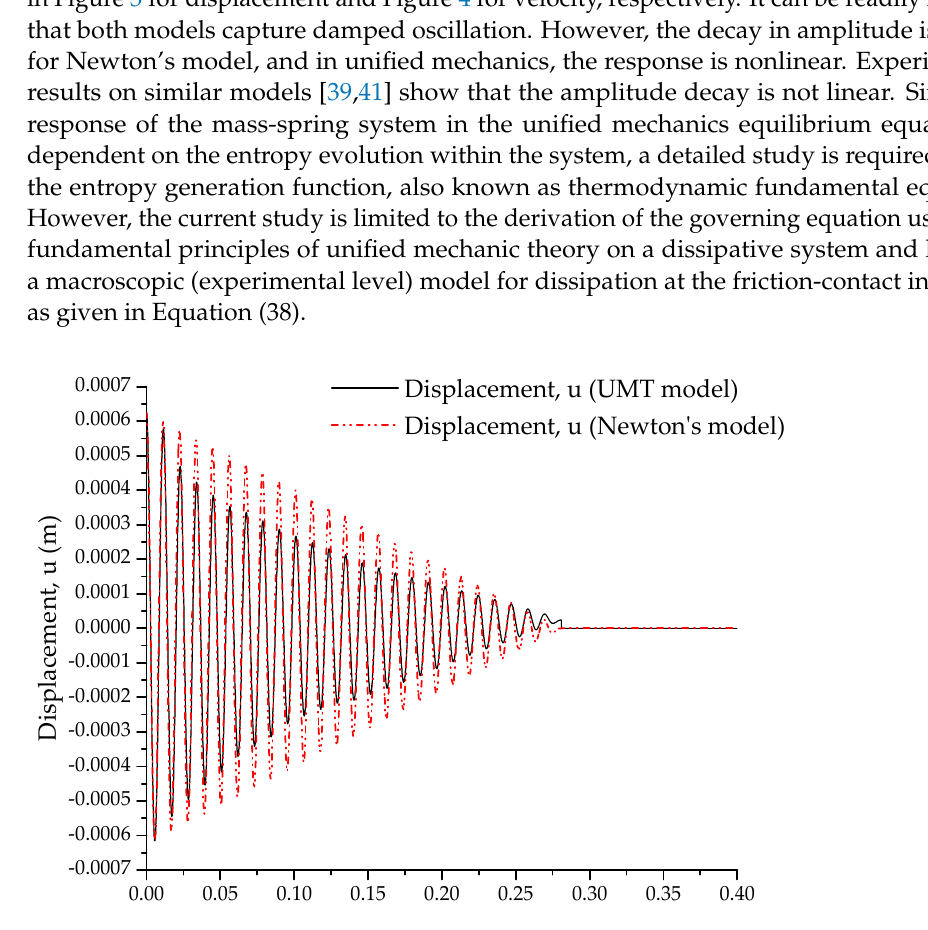
Figure 3. Position versus time for a damped oscillator in the presence of contact surface friction.